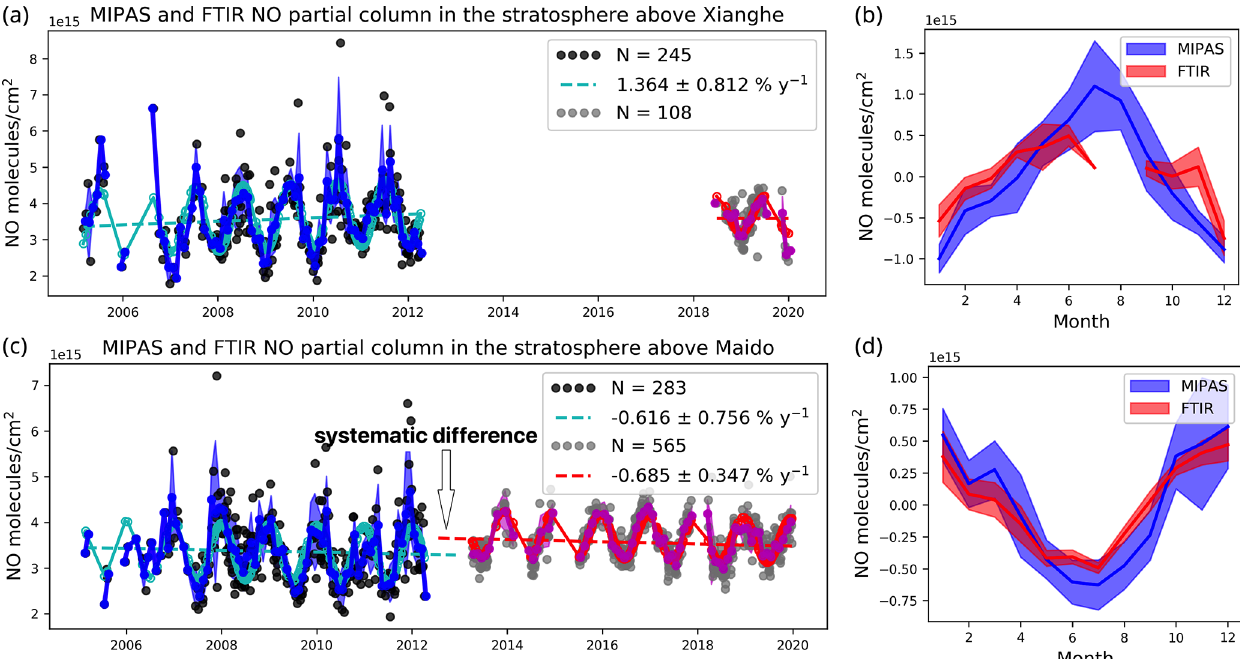
Figure 9. (a, c) The time series of the stratospheric NO partial columns observed by MIPAS measurements (black dots: daily means; solid blue line: monthly mean; blue shadow: monthly SD; dashed cyan line: trend fitting) and FTIR measurements (gray dots: daily means; solid purple line: monthly mean; purple shadow: monthly SD; dashed red line: trend fitting) above Xianghe (a, b) and Maïdo (c, d) . (b, d) The seasonal variations in the stratospheric NO partial columns observed by MIPAS measurements. The MIPAS measurements are selected within ± 2 ◦ latitude and ± 2 ◦ longitude around the sites. Numbers of the measurement days ( N ) are 245 and 283 from MIPAS at Xianghe and Maïdo, respectively. The FTIR measurements are selected with the measurement time between 09:30 and 11:30LT, with 108 and 565d at Xianghe and Maïdo, respectively. The annual changes in NO partial columns are derived from MIPAS measurements at Xianghe and Maïdo in 2005–2012 and from the FTIR measurements at Maïdo in 2013–2019. A systematic difference is detected between the MIPAS and FTIR NO stratospheric partial